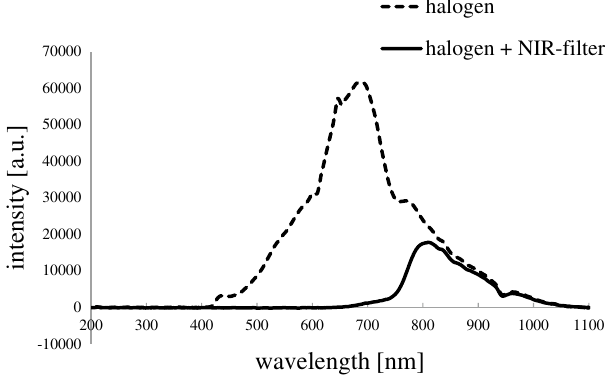
Figure 2. The applied system’s spectrum for blood PBM consists of a halogen reflector and a broadband NIR filter. The transmission of electromagnetic radiation in this system starts with a rising slope, which begins at approx. 700 nm. Then, two bands can be distinguished—the first, wide, with a maximum intensity of 800 nm, and the second, of low intensity, with a maximum of 960 nm. The radiation intensity consisted of 86% of the NIR spectral range waves, while 14% were electromagnetic waves from the red light